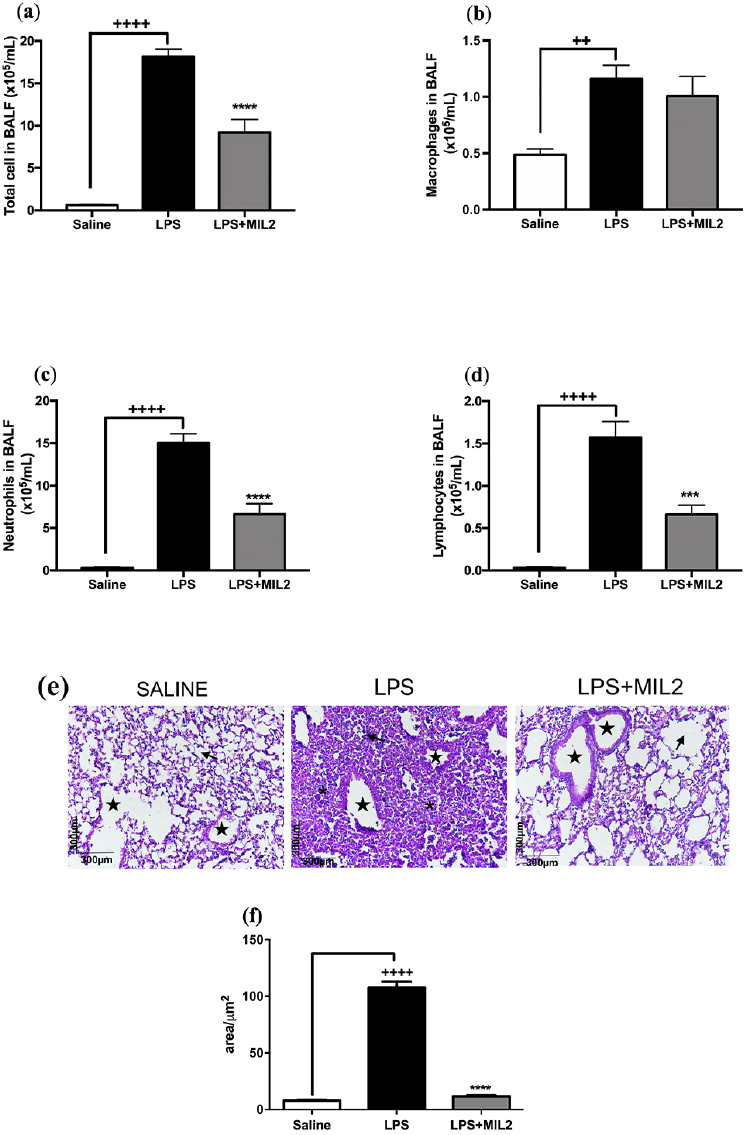
Figure 2. Effect of milonine on lung damage in LPS-induced acute lung injury. BALB/C mice (n = 6) were LPS-challenged and treated with milonine (2.0 mg/kg; LPS+MIL2; p.o) or vehicle (LPS group). The saline group was saline-challenged. The bronchoalveolar lavage fluid (BALF) was recovered 24h after the challenge and evaluated: the total number of cells (a), macrophages (b), neutrophils (c), lymphocytes (d), the lungs recovered for histological (e) and morphometric (f) analysis. The photomicrograph images show the lung sections stained with H&E with total magnification x200 (300 µm). Asterisks (*) indicate cell infiltration, (arrow) pulmonary alveoli, and (star) bronchioles. The results represent the mean ± SEM and submitted to the one- way ANOVA analysis of variance, followed by the Tukey post-test ++ p <0.01, ++++ p <0.0001 comparison between LPS and saline groups; **, p <0.01, *** p <0.001, **** p <0.0001 for comparison of the group treated with milonine and the LPS